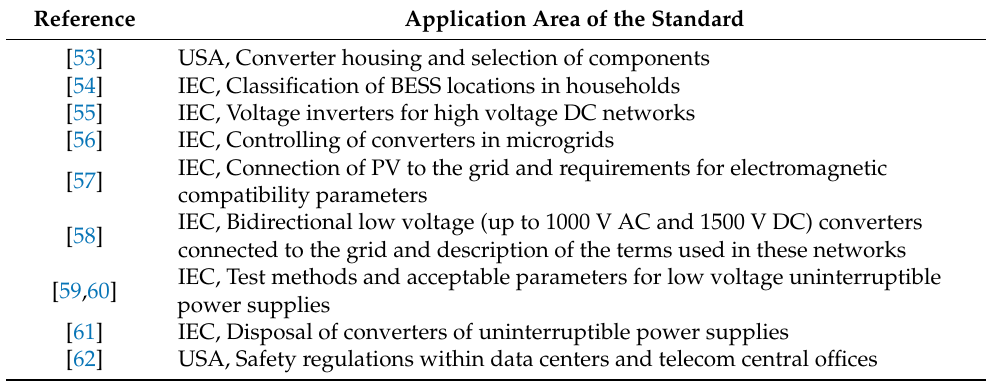
Table 1. Summary of Standards and Regulations applicable to